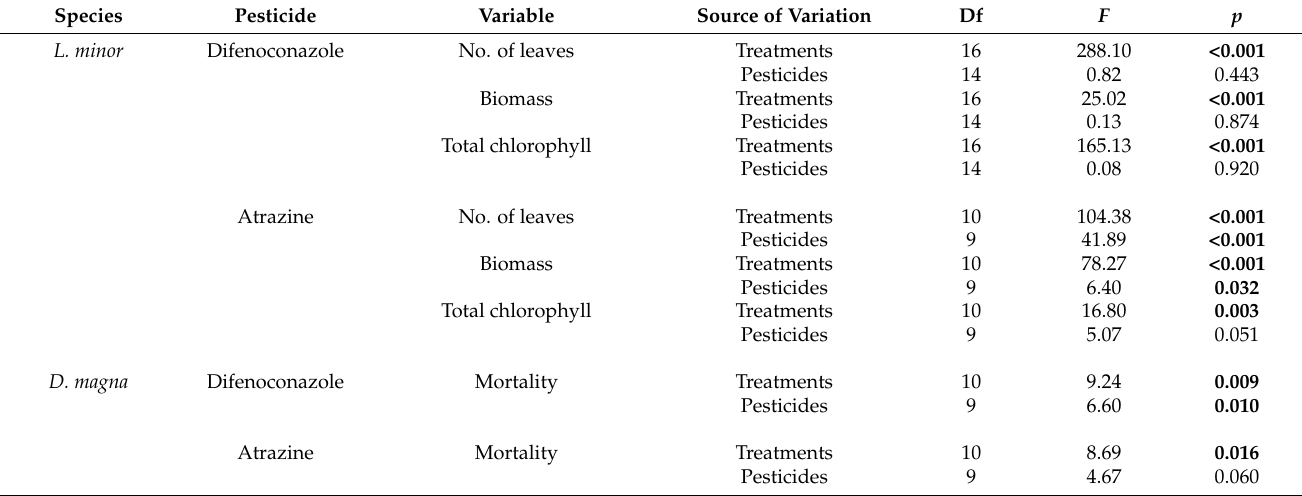
Table 3. Summary of the GLM for the number of leaves, biomass, and total chlorophyll of L. minor and for the percentage of mortality of D. magna after being exposed to different concentrations (treatments) of pesticides and their photodegradation products (pesticides). Significant differences are indicated with the p -values in